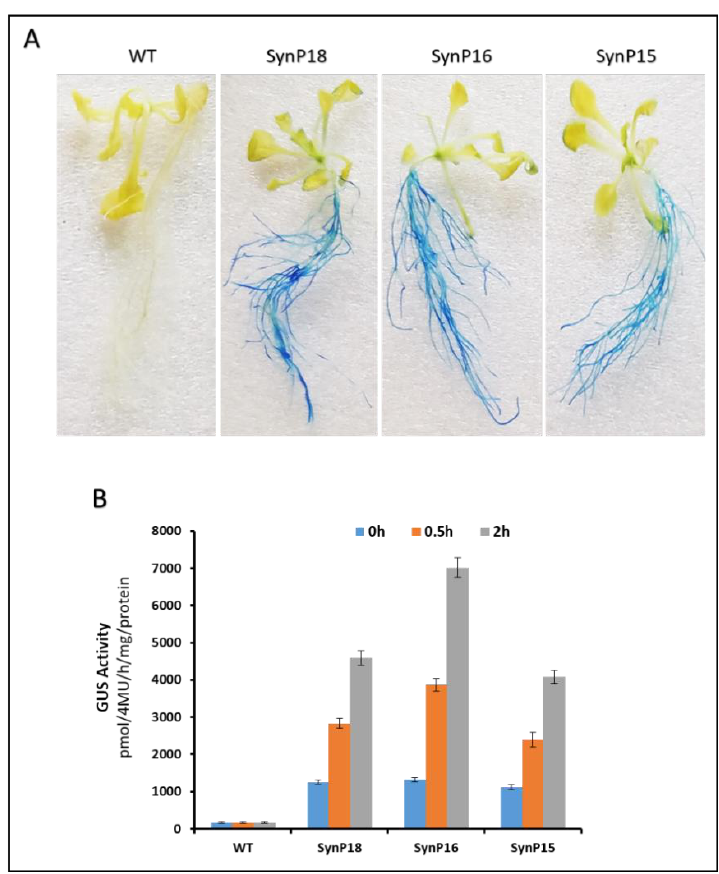
Figure 7. Functional validation of synthetic promoters in Arabidopsis. The three synthetic promoters (SynP15, SynP16, and SynP18), which displayed efficient drought inducibility in soybean hairy roots were further validated in Arabidopsis through their Agrobacterium tumefacians -mediated transformation (WT Arabidopsis as negative control). ( A ) WT as well as transgenic Arabidopsis were subjected to GUS histochemical assay after treating with 20% PEG6000 for 24 h. ( B ) GUS fluorometric analysis of WT and transgenic Arabidopsis.